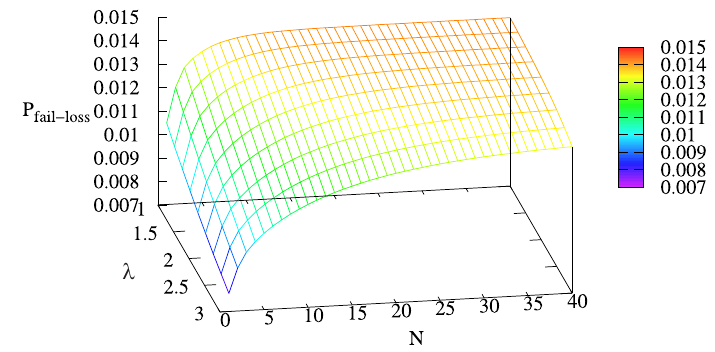
Figure 7. Dependence of the probability P fail − loss on N and λ .